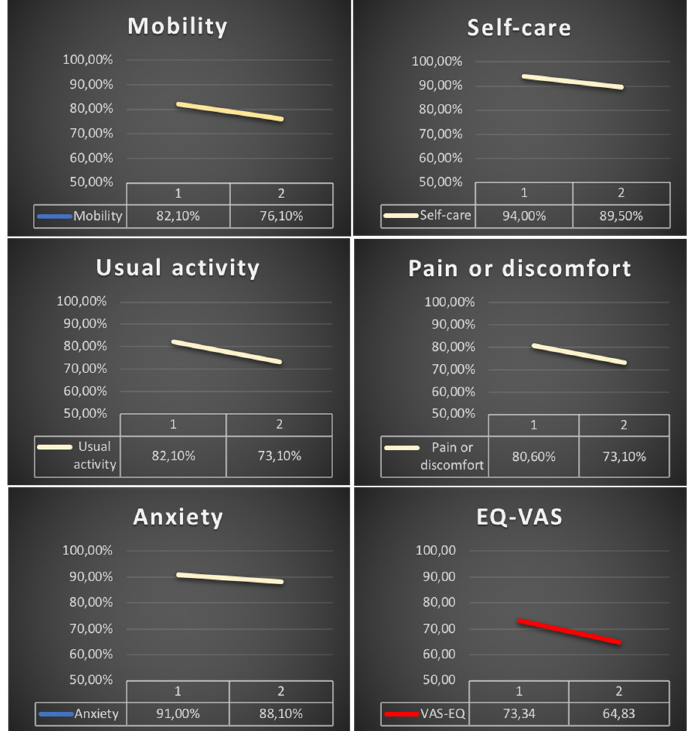
Figure 4. KTR with no problems with quality of life in five dimensions of EQ-5D-5L (yellow lines) and health related quality of life in EQ-VAS questionnaire (red line) before COVID-19 ( 1 ) and 6 months after recovery ( 2 ).